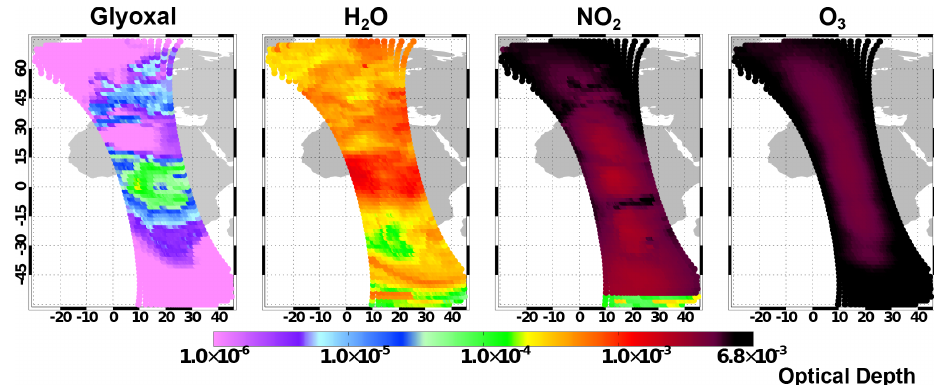
Figure 2. Simulated optical depths of important species in the glyoxal fitting region for 1 July 2006. The values correspond to the mean optical depths within the 430–460nm spectral region. Results were simulated using the VLIDORT radiative transfer model run using the viewing geometry of OMI combined with GEOS-Chem trace gas